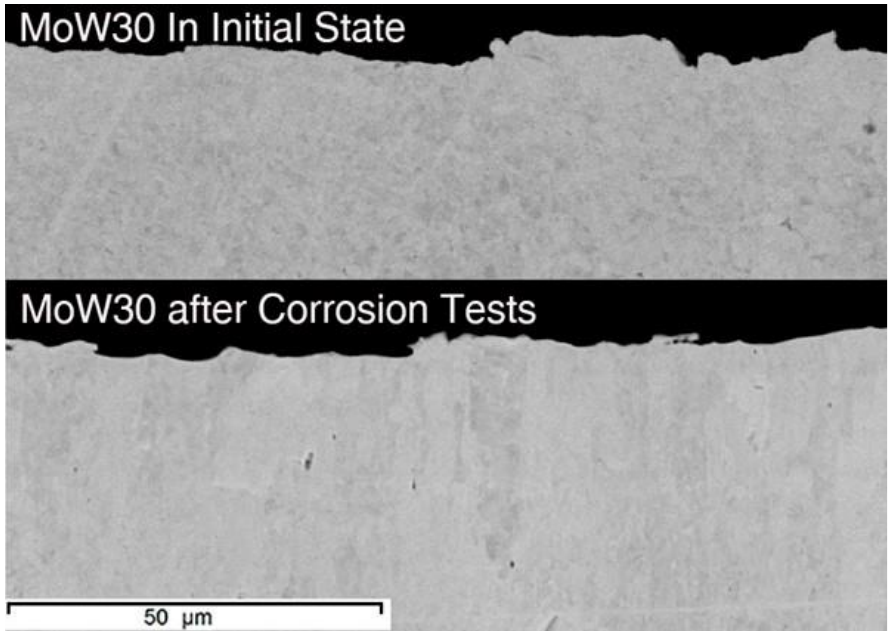
Figure 4. BSE-SEM images of microstructure of MoW30 alloy samples before and after contact with BLA at 650 °C for 100 h.